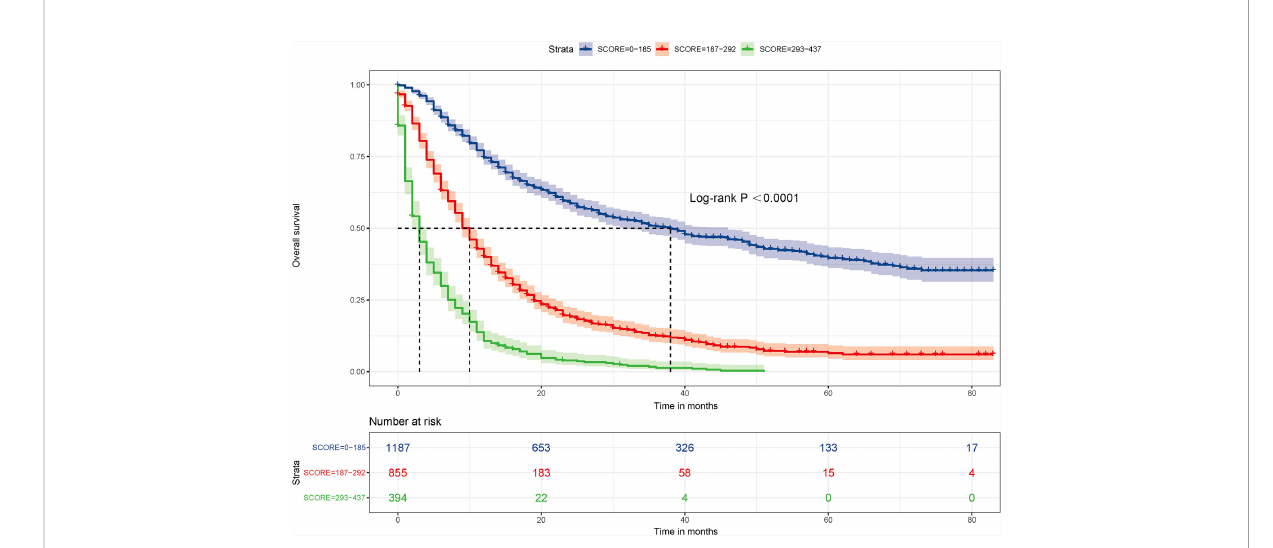
FIGURE 6 Survival bene fi t of surgery in the low-risk, intermediate-risk, and high-risk